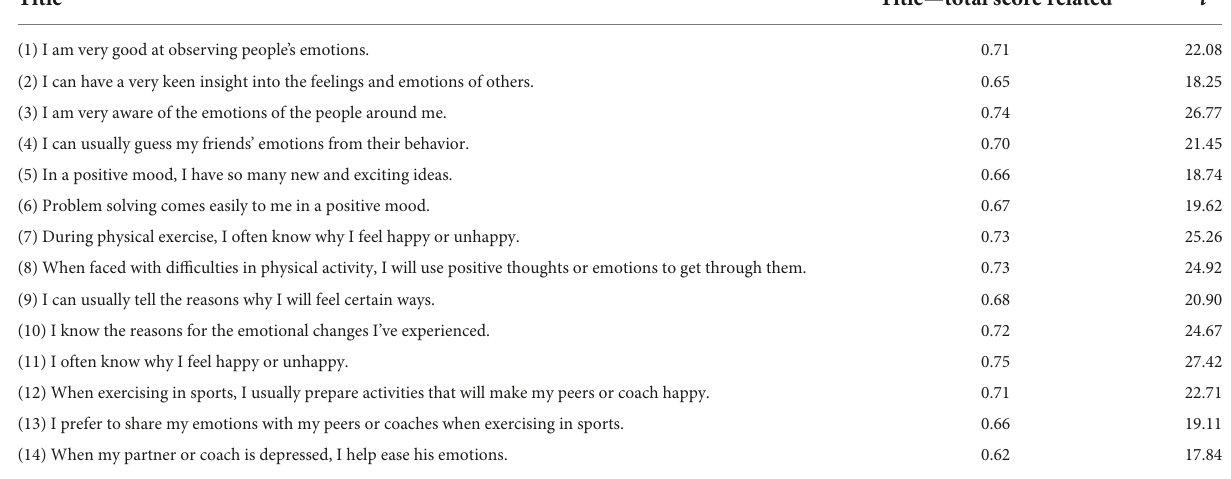
TABLE 1 Descriptive statistics and